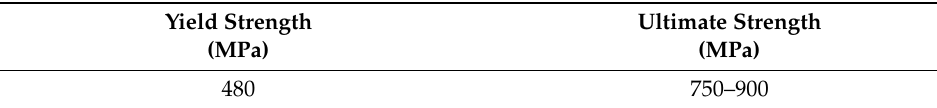
Table 3. Mechanical properties of the material